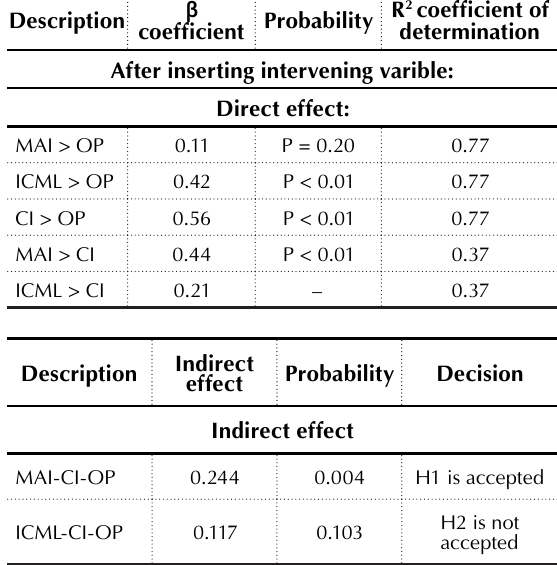
Table 7. Direct and indirect effect evaluation with continuous improvements as mediating variable